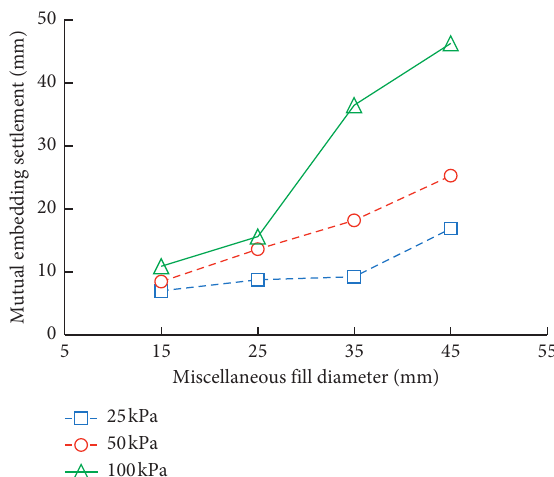
Figure 7: Relationship between the mutual embedding settlement and miscellaneous fill diameter.